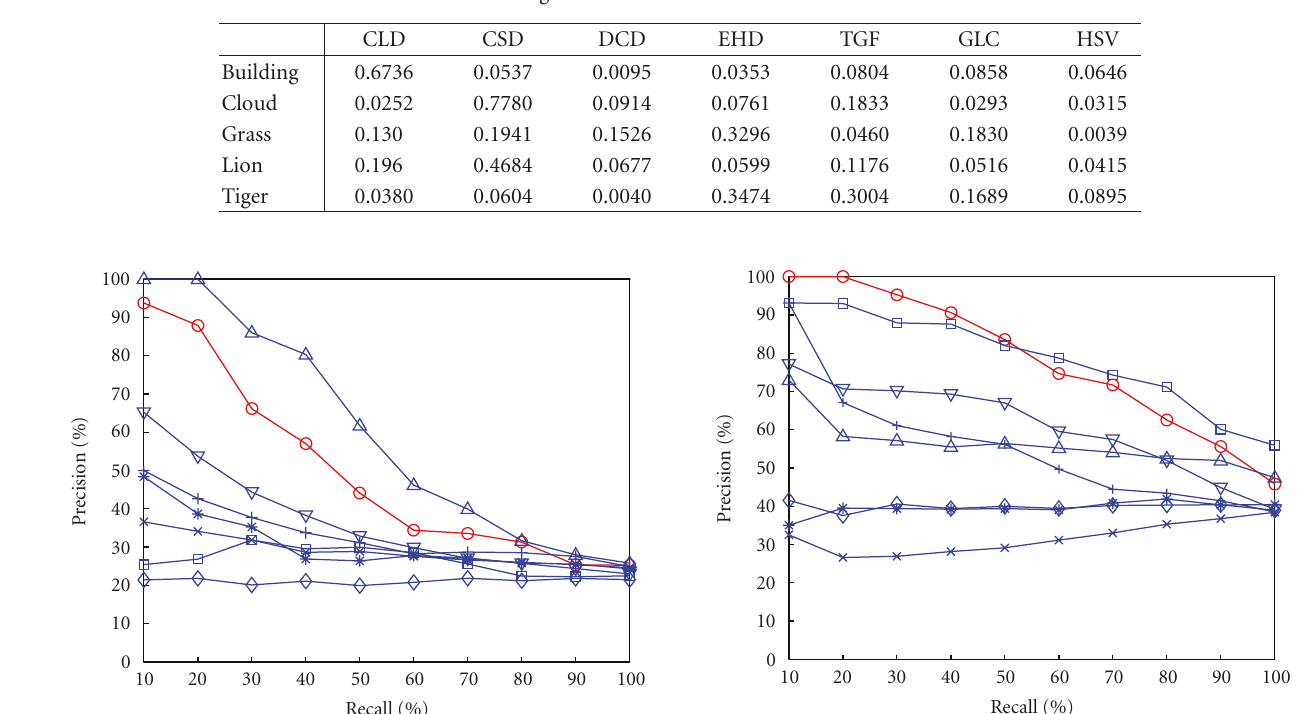
Table 2: Weights obtained after 10000 iterations of PAES.